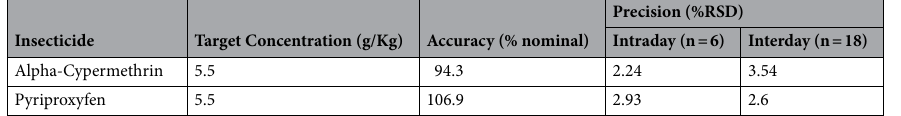
Table 5. Precision and accuracy of alpha-cypermethrin and pyriproxyfen extracted from Royal Guard® LLIN.